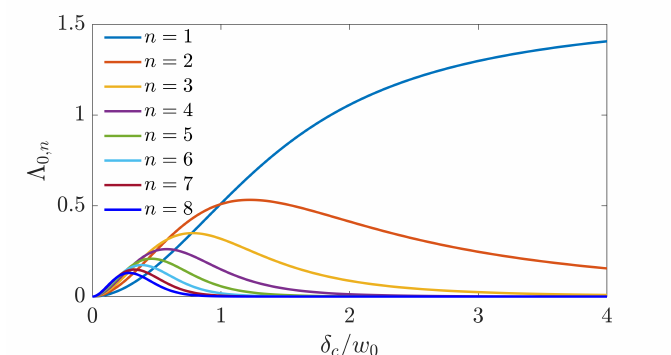
Figure 3. Pseudo-eigenvalues, Λ m , n = n 2 β 2 m , n , for the CSD in Equation (10) with m = 0 as functions of the ratio δ c / w 0 . The values of β m , n are evaluated from Equation (15).